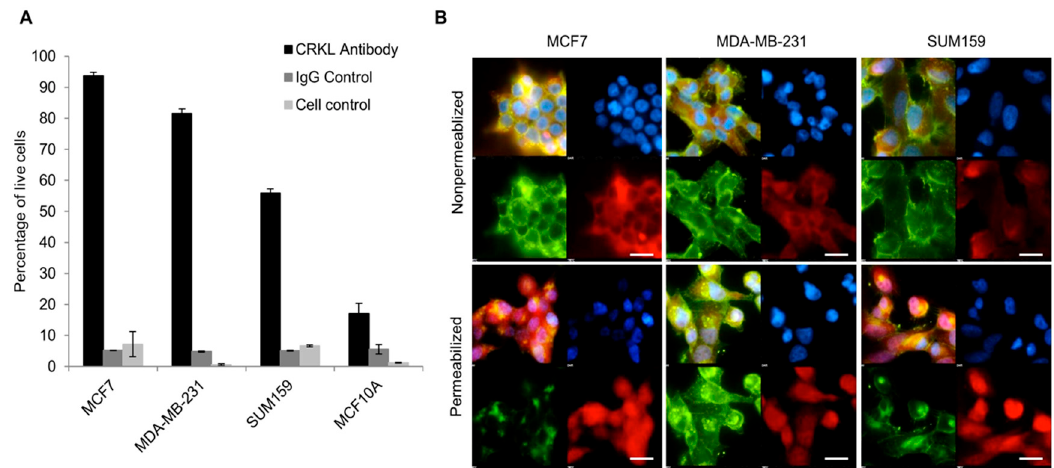
Figure 1. Intracellular and membranal localization of Crk-like protein (CrkL) in vitro in breast cancer cells. ( A ) Flow cytometry on non-permeabilized cells showing surface fraction of CrkL in breast cancer cells (MCF7, MDA-MB-231, and SUM159) versus normal breast epithelium cells (MCF10A), the data is presented as percentage of fluorescently labeled cells from all live cells, n = 6; p < 0.001 comparing the percentage of all the evaluated breast cancer cells with membranal fraction of CrkL versus MCF10A cells; ( B ) immunofluorescence images of human breast cancer monolayers showing the difference in the staining pattern of CrkL ( red ) in permeabilized ( bottom row ) and non-permeabilized ( top row ) cells. The cells are counterstained with wheat germ agglutinin 488 for the cell membrane ( green ) and 4 ′ ,6-diamidino-2-phenylindole (DAPI) for the nucleus ( blue ). (Scale bar = 20µm).